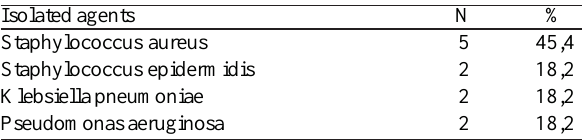
Table 1. Analysis of etiologic agents in cases of mediastinitis in the postoperative period by the culture of exudates.